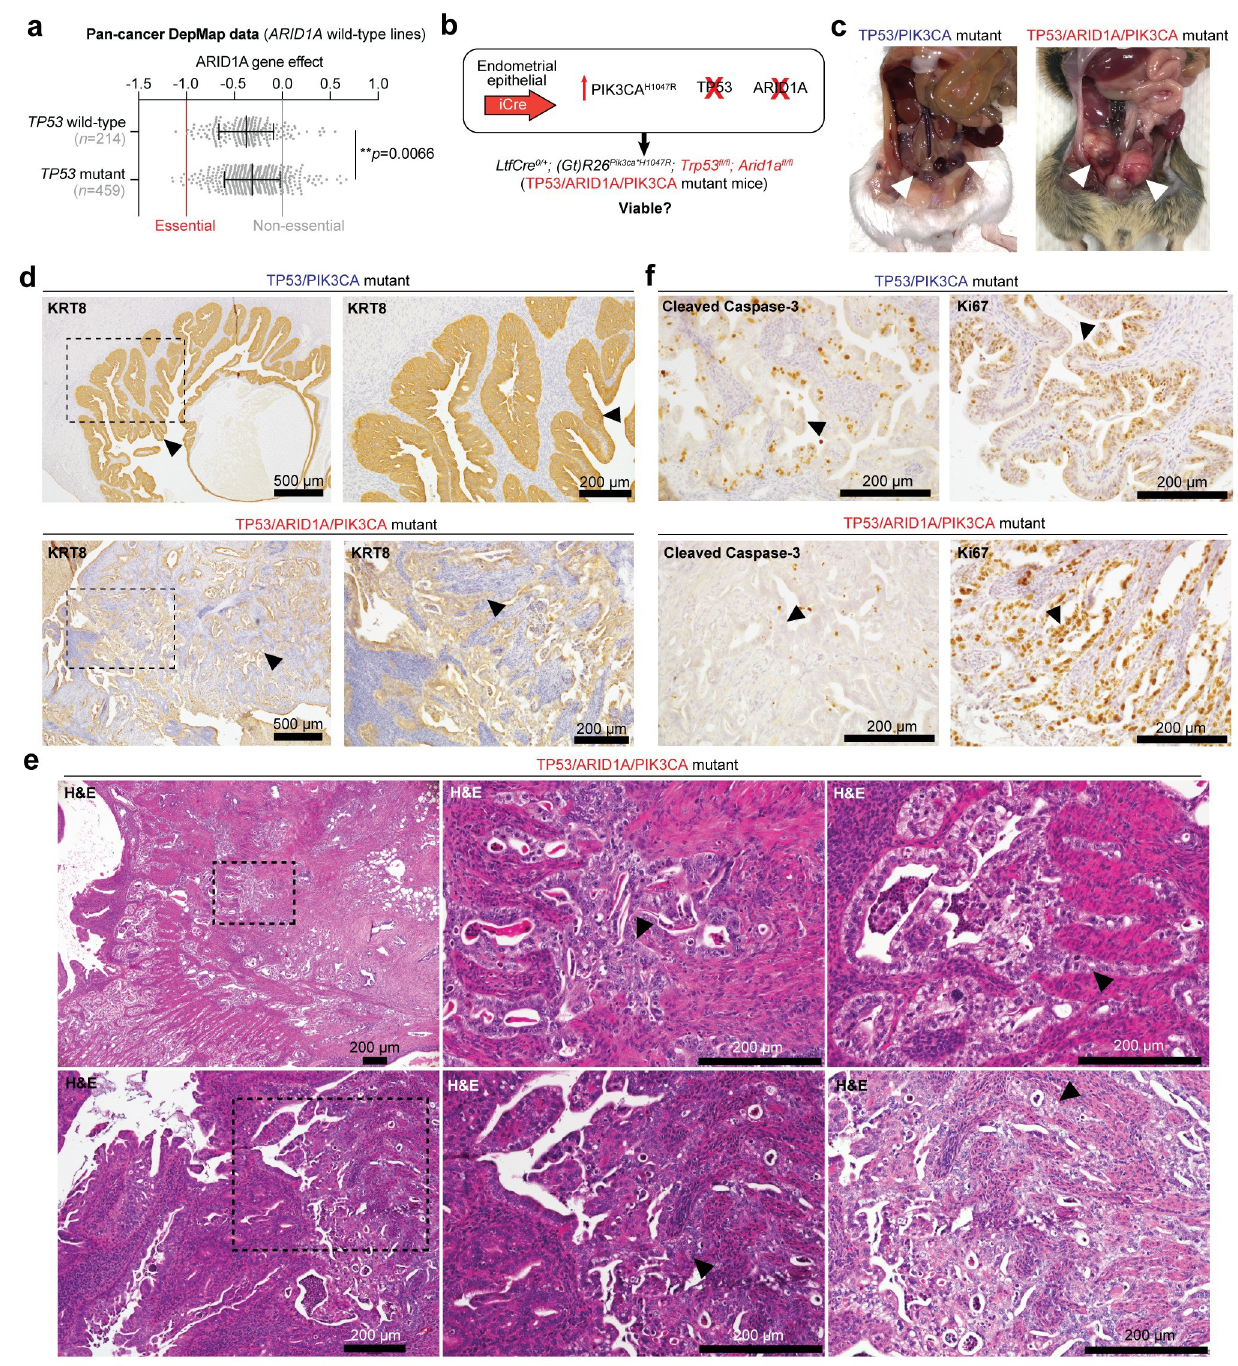
Fig 7. Co-existing TP53 and ARID1A mutations promote aggressive endometrial tumorigenesis. a , Cancer dependency map (DepMap) data for ARID1A wild-type cell lines, measuring ARID1A knockout viability effect on TP53 wild-type vs. mutant lines. Statistic is unpaired, two-tailed Wilcoxon test. b , Schematic of genetically engineered mice harboring endometrial epithelial specific PIK3CA H1047R , TP53 loss, and ARID1A loss. c , Example gross necropsy images in TP53/PIK3CA mutant (top) and LtfCre 0/+ ; (Gt)R26 Pik3ca � H1047R ; Trp53 fl/fl ; Arid1a fl/fl (TP53/ARID1A/PIK3CA mutant, bottom) mice. Arrowheads denote uterine abnormalities. d , Immunohistochemical staining of KRT8 staining in TP53/PIK3CA and TP53/ARID1A/PIK3CA mutant uterus. Arrowheads denote mutant endometrial epithelial cells. In TP53/ARID1A/PIK3CA mutant image. e , Representative H&E uterine histology images of TP53/ARID1A/PIK3CA mutant mice. Arrowheads depict mutant tumor cells with squamous differentiation. f , Uterine IHC staining for Cleaved Caspase-3 (cell death, left) and Ki67 (proliferation, right) in TP53/PIK3CA mutant (top) and TP53/ARID1A/PIK3CA mutant (bottom) mice. Arrowheads denote endometrial epithelial